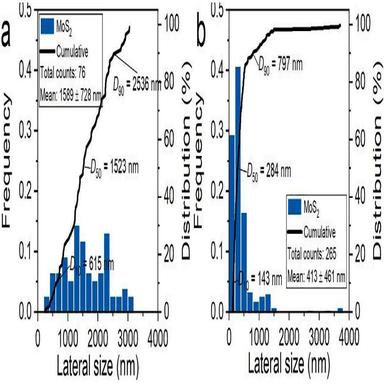
Histograms and distributions of the lateral size of the MoS2 flakes as measured by (a) SEM and (b) AFM.